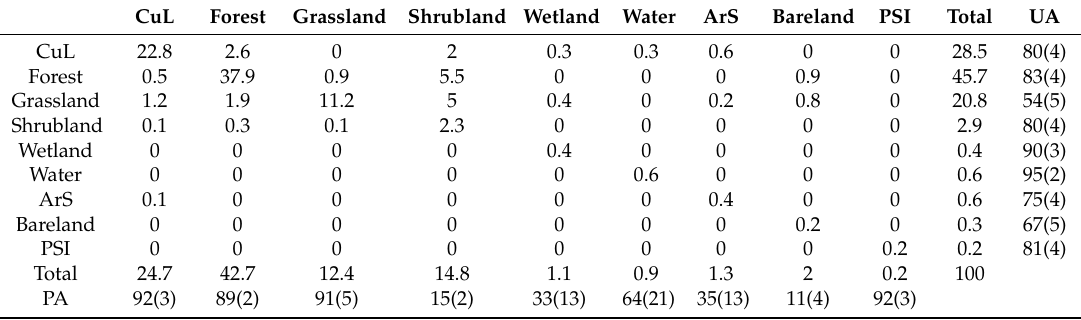
Table A5. The error matrix of estimated area proportions for R5: Overall accuracy is 87.7% (2.0%).